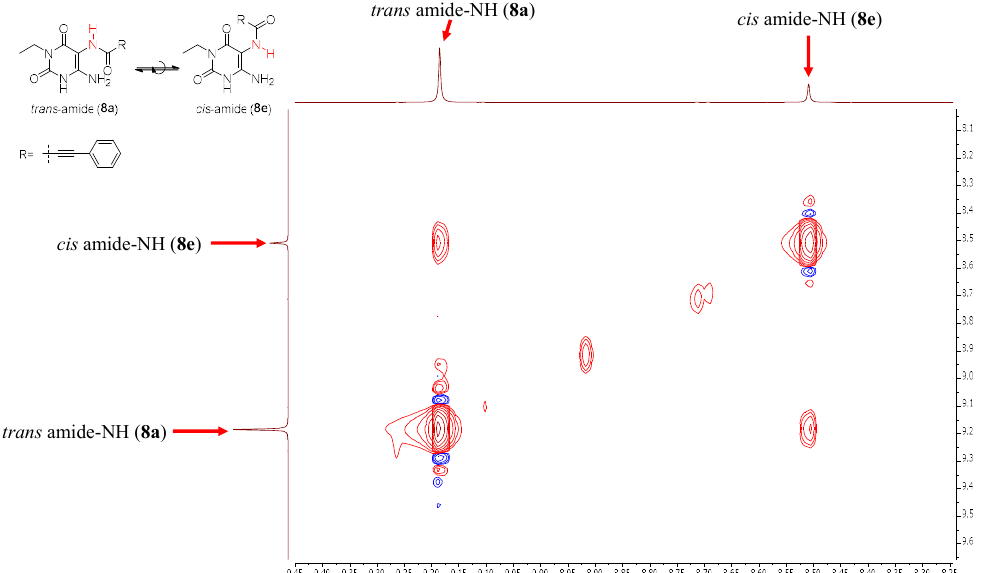
Figure 4. Exchange spectroscopy (EXSY)-NMR spectrum of 8a in DMSO- d 6 indicating cross-correlation in phase between the two amide-NH protons of conformer 8a and 8e . EXSY cross peaks of the cis -amide NH at 8.50 ppm and the trans -amide NH at 9.20 ppm are shown.